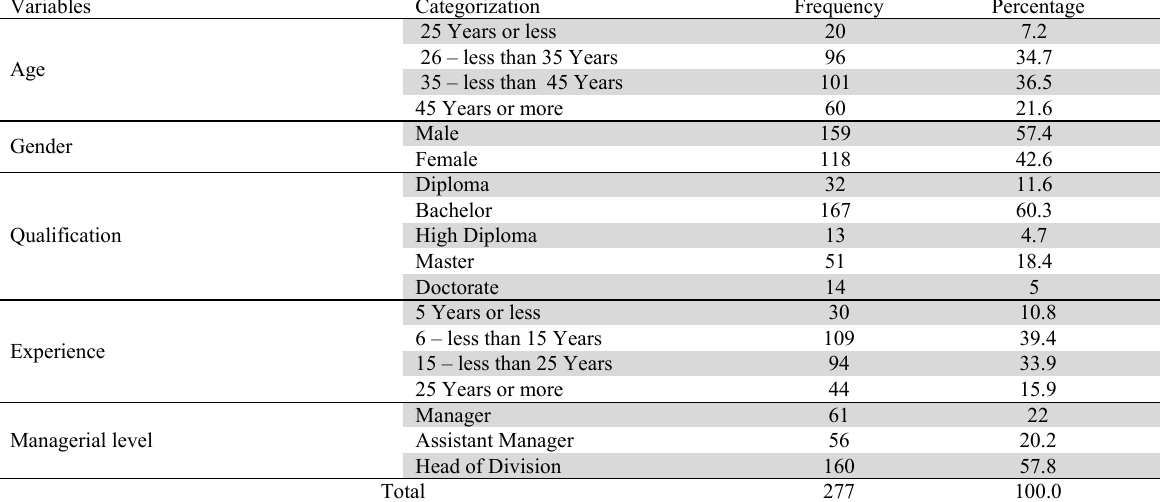
Descriptive analysis of characteristics of study sample